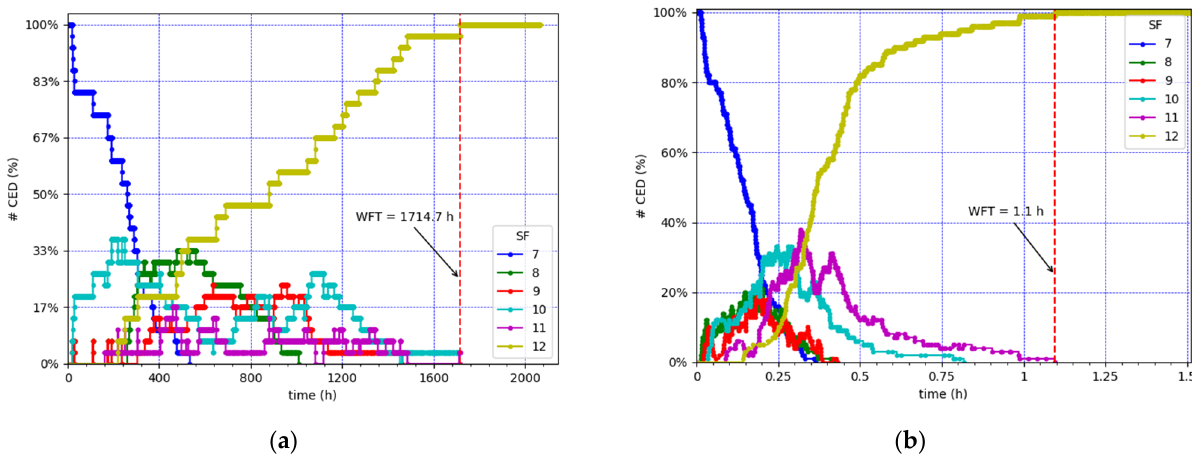
Figure 5. Percentage of CEDs using each SF value over time. ( a ) Lowest load: 30 CEDs, using an EDL of 0.9 packets/h. ( b ) Highest load: 100 CEDs, using an EDL of 18 packets/h.